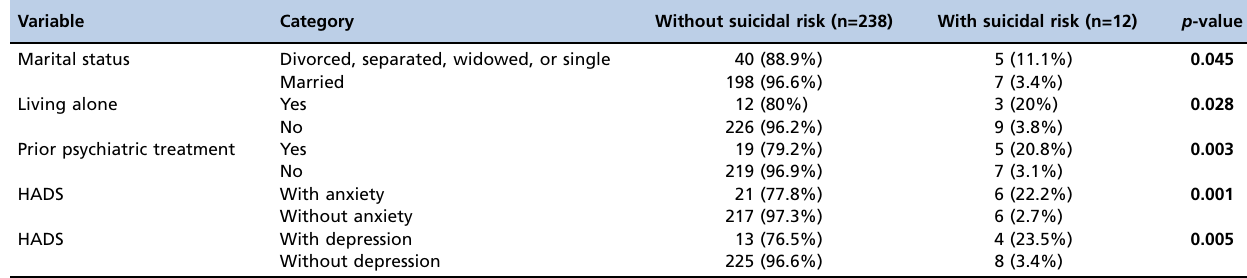
Table 1 - Sociodemographic and clinical data of patients with and without risk of suicide.